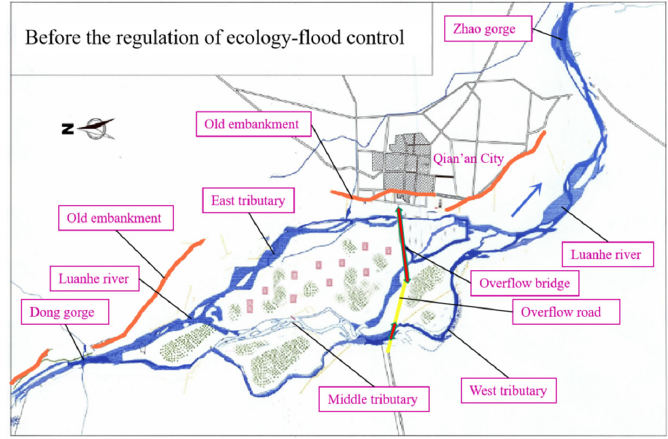
Figure 1. Sketch of the Qian’an reach of the Luanhe River.